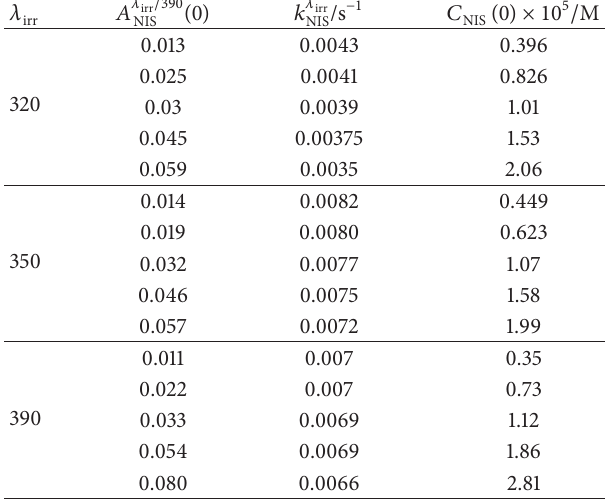
Figure 5: A linear relationship between the overall rate-constant of NIS photodegradation (obtained as the fitting parameter of the kinetic data with (1)) and the photokinetic factor of the photoprod- uct (calculated using (3)) when irradiating various concentrations of NIS solutions (0.39–2.06 × 10 −5 M) at 320 nm and observing at 390 nm. Table 2: Initial concentrations and overall rate-constants of NIS photodegradation measured at various irradiation